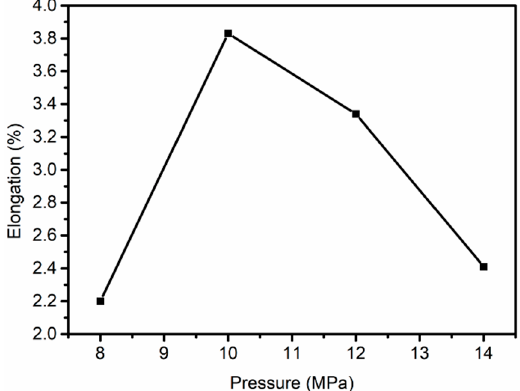
Figure 9. Elongation of PAN fibers at different pressures in Sc ‐ CO 2 .